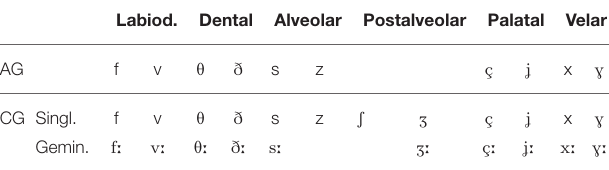
TABLE 1 | Athenian Greek (AG) and Cypriot Greek (CG) fricative consonants. Labiod. Dental Alveolar Postalveolar Palatal